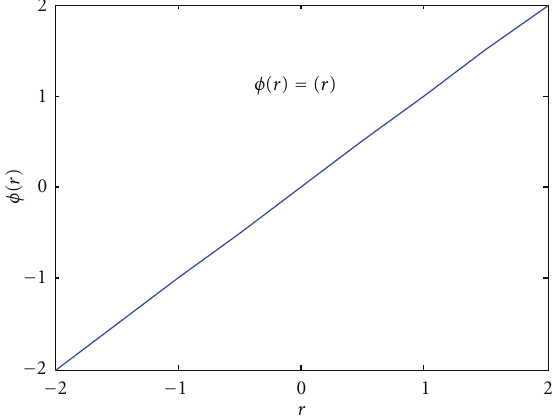
Figure 6: Linear splines radial basis function, φ ( r ) = r .